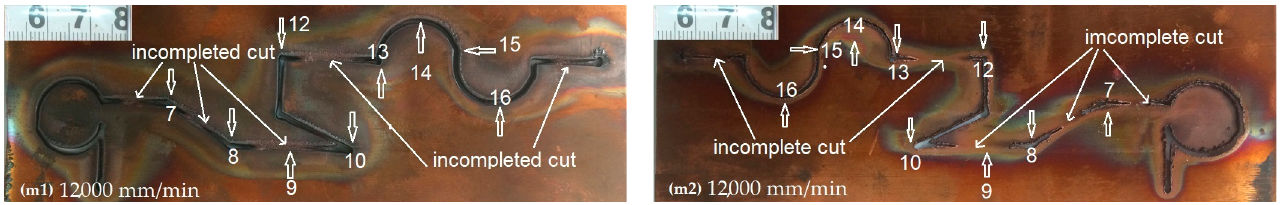
Figure 9. The cutting path width of ( m1 , m2 ) at 12,000 mm/min at 30 A for Points 7, 8, and 9. At 12,000 mm/min, Point 8 (the obtuse angle on the cutting path) recorded a lower cutting width of 1.754 mm (Figure 9). At 4000 mm/min, the same point recorded (Figure 7) an average reading of the cutting width of 2.591 mm (most of the readings for the rest of the specimens were below average). This also confirmed that the cutting width at the obtuse angle was increased by decreasing the cutting feed rate and decreasing the cutting quality. The cutting width of Point 9, which was located on the straight line on the cutting